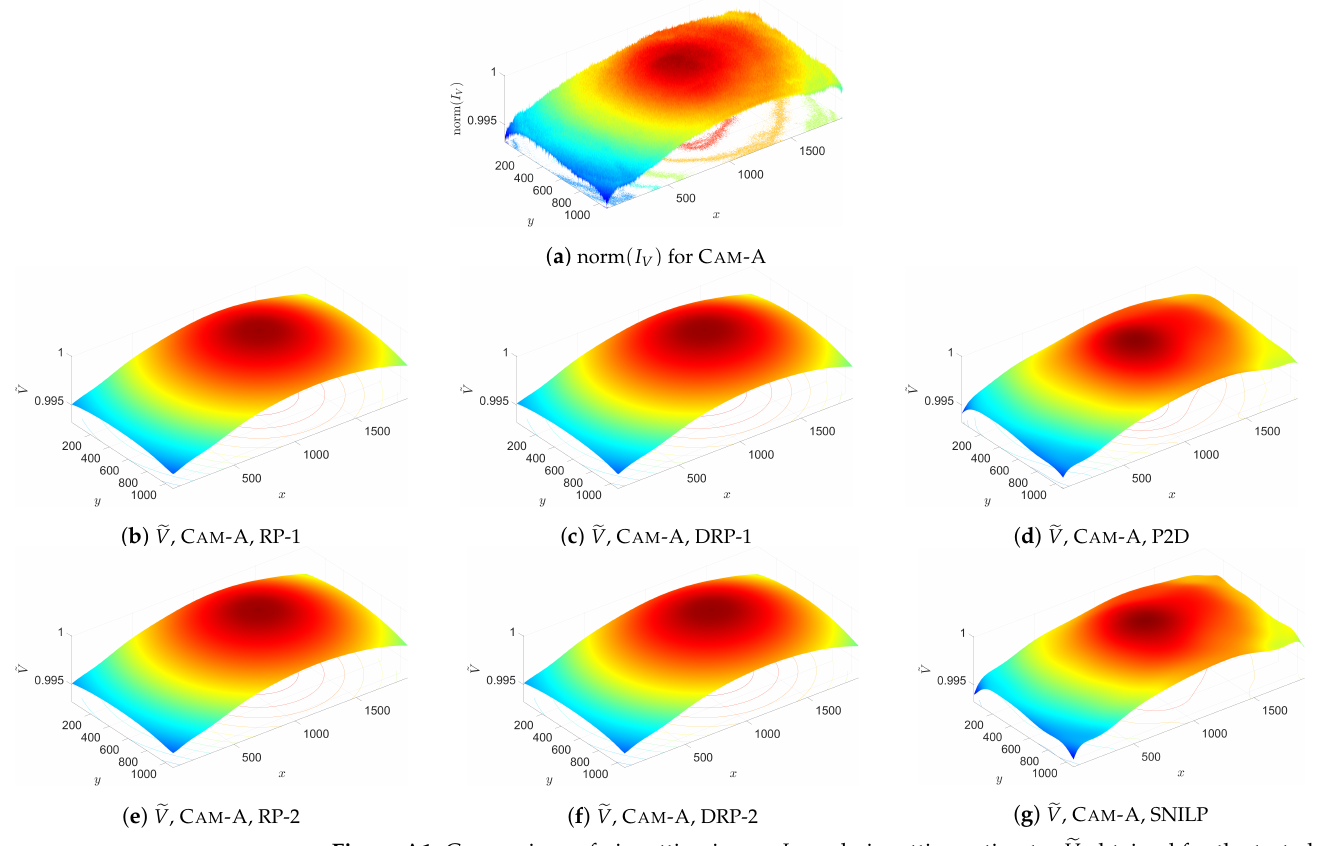
Figure A1. Comparison of vignetting image I V and vignetting estimates (cid:101) V obtained for the tested models and C AM -A.